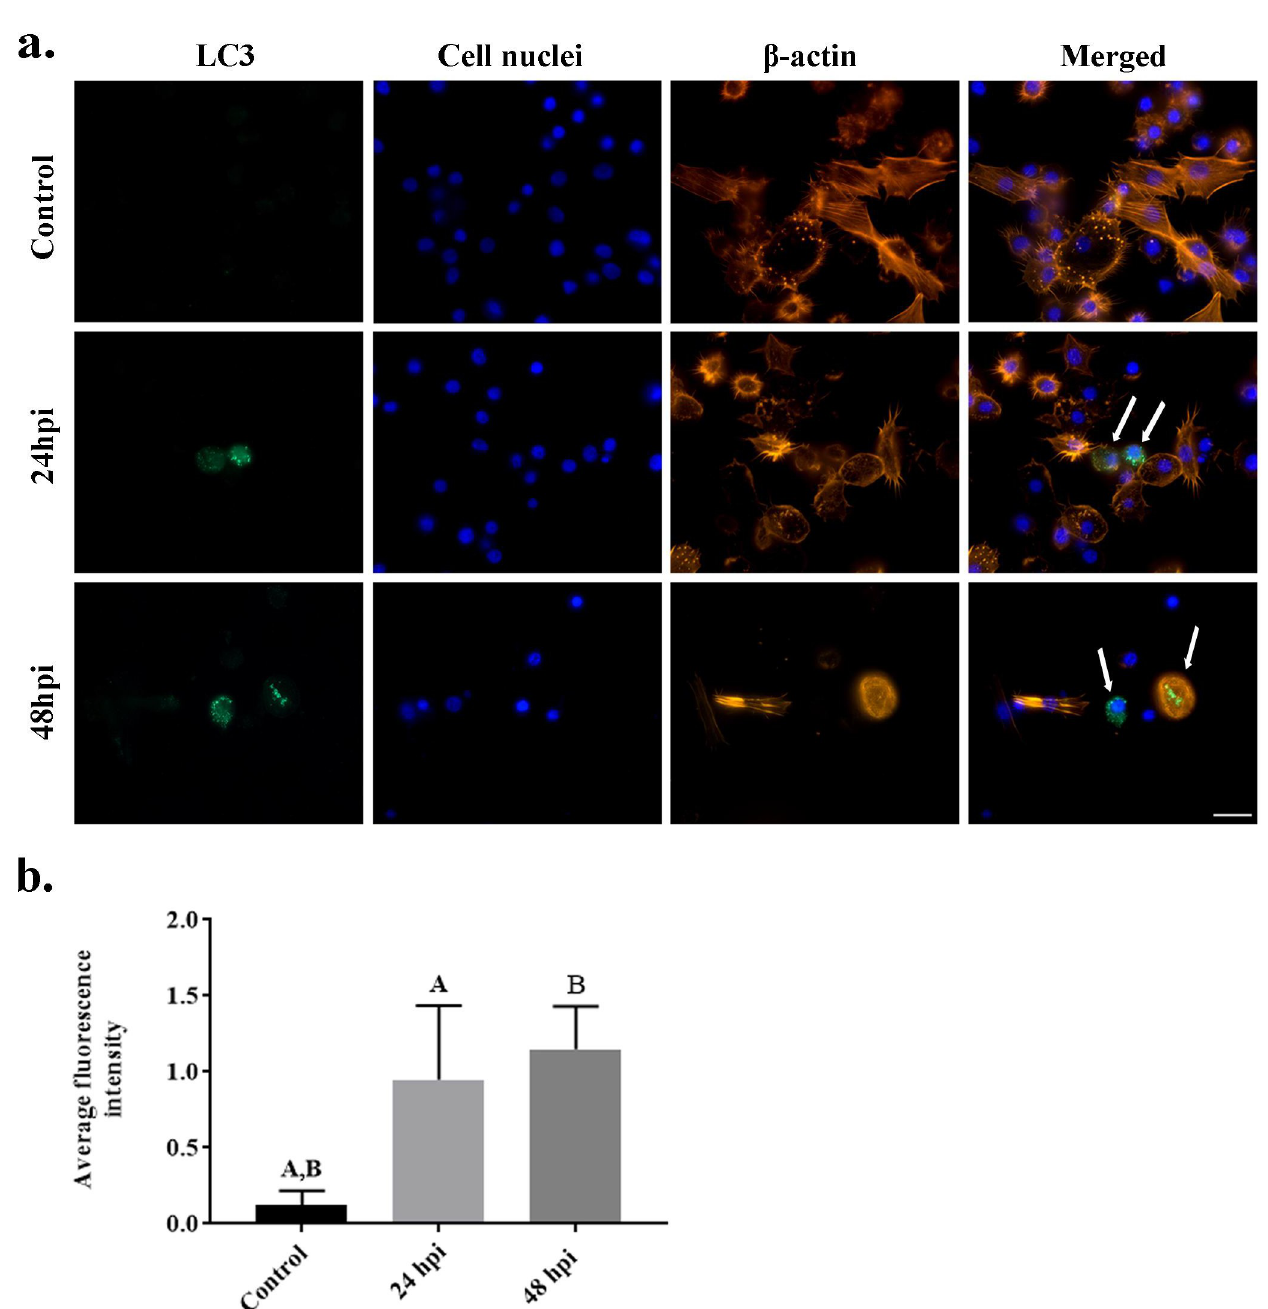
Fig 6. Hemocytes of Galleria mellonella control larvae, 24 hours post infection and 48 hours post infection with the entomopathogenic fungus Conidiobolus coronatus . (a) The intensity of autophagosomes was evaluated by CYTO-ID 1 Autophagy Detection Kit staining and (b) their average fluorescence intensity was quantified. Blue color–nuclei labelled by DAPI (Ex/Em: 345/455 nm); Green color– 488nm-excitable green fluorescent detection reagent CYTO-ID 1 Autophagy Detection Kit (Ex/Em: 495/518 nm). Scale bar 20 μ m.